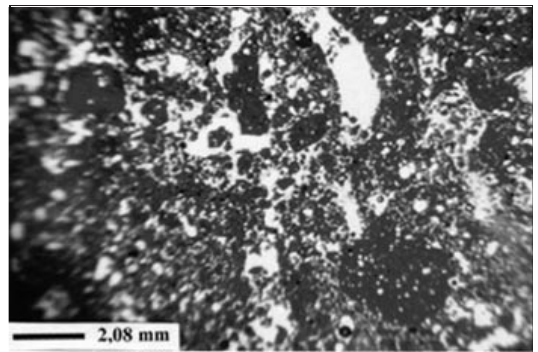
Figura 6. Fotomicrografia em luz plana do horizonte superficial do LE (P7), mostrando a forte influência da fauna do solo na organização da microestrutura.